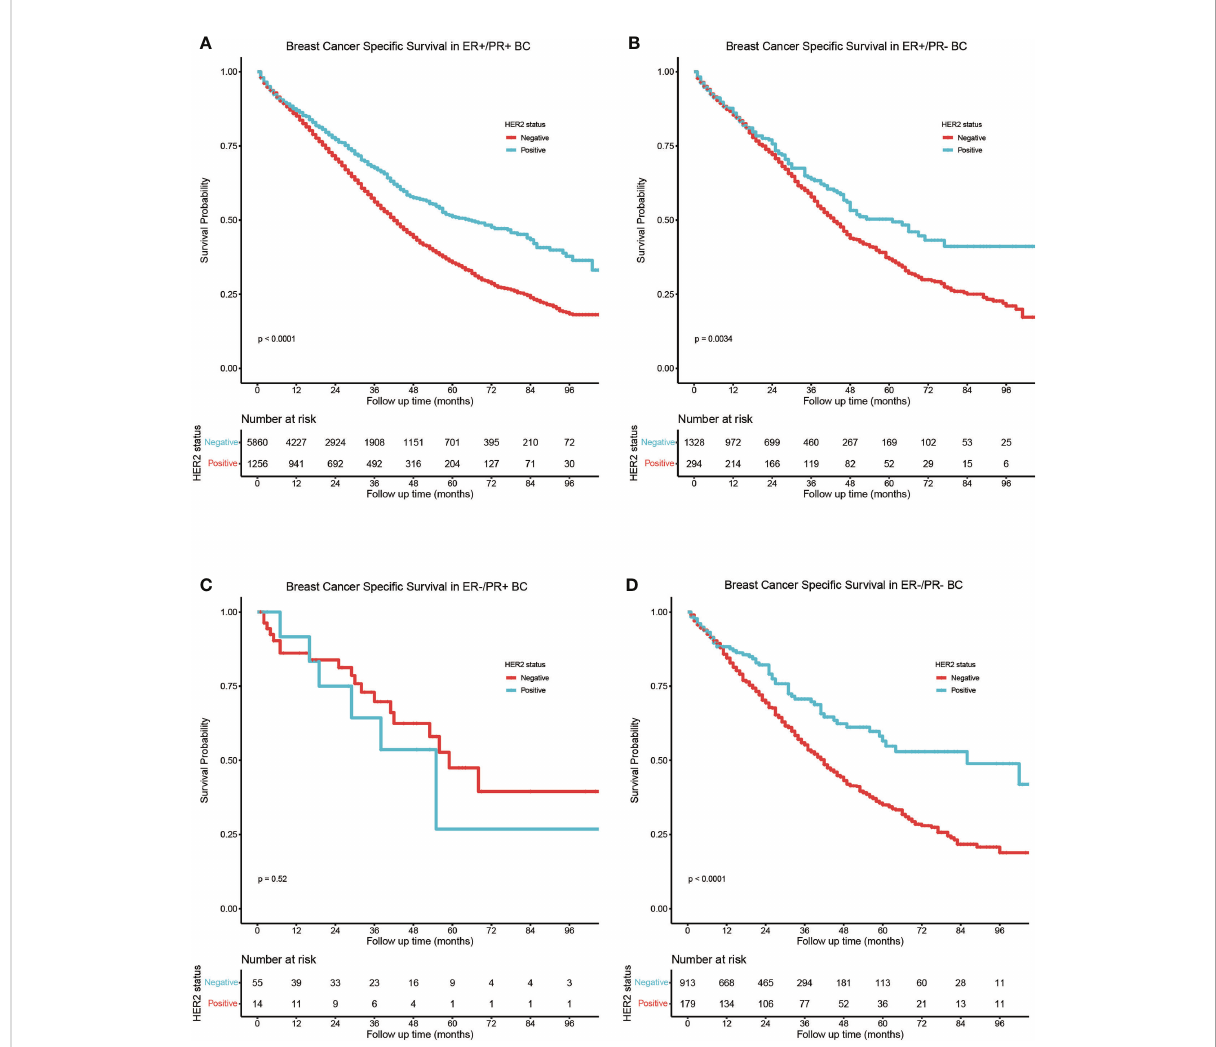
FIGURE 4 Subgroup BCSS analysis in (A) ER-positive/PR-positive, (B) ER-positive/PR-negative, (C) ER-negative/PR-positive, and (D) ER-negative/PR- negative bone metastatic breast cancers strati fi ed by HER2